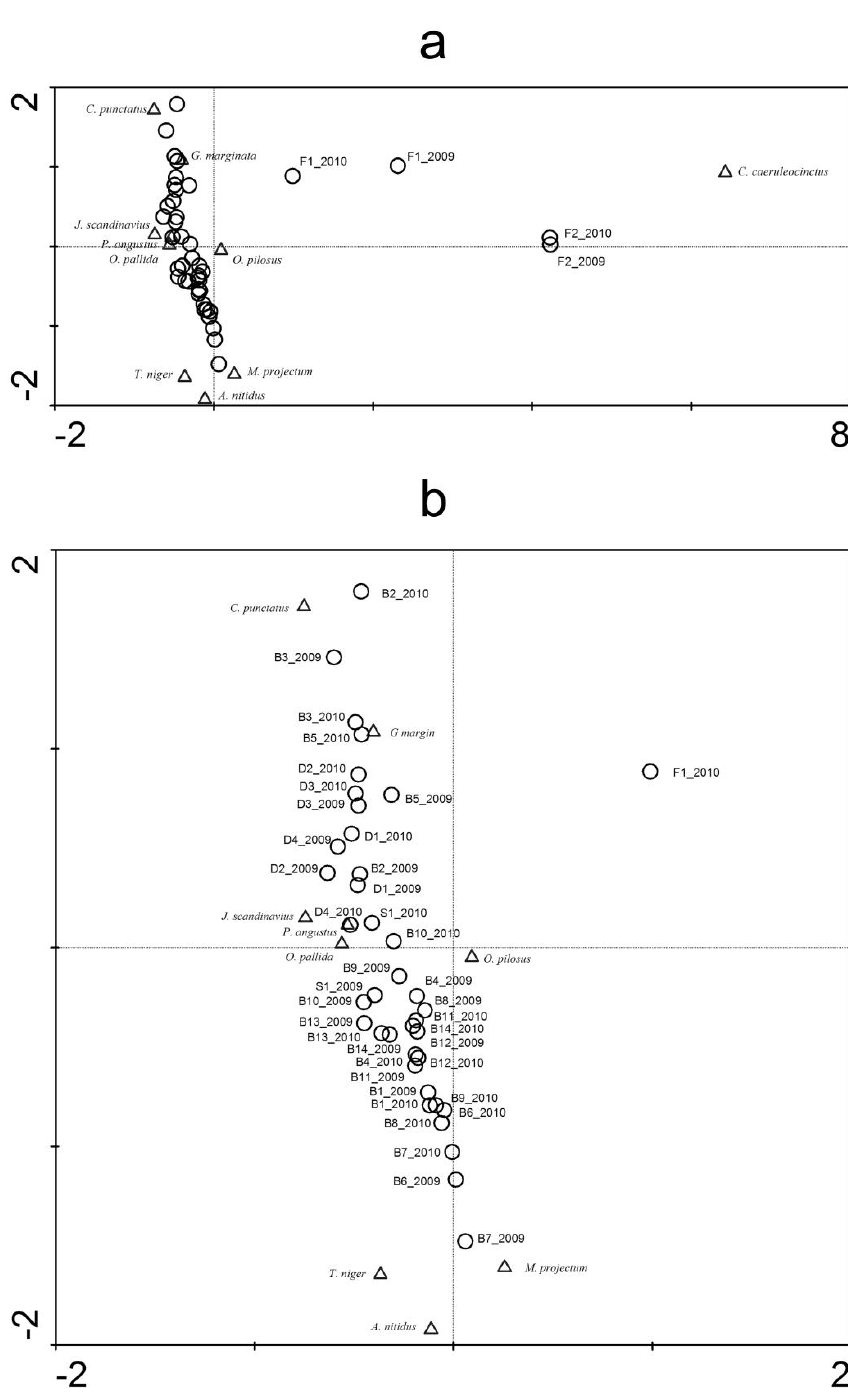
Three traps were placed in each site by keeping a distance of 5–10 m between individual traps. Boundary e ff ects were avoided by placing the traps at least 20 m away from the site’s edges (den Boer,